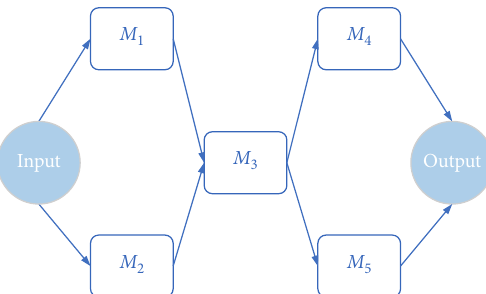
Figure 1: The relationship among five